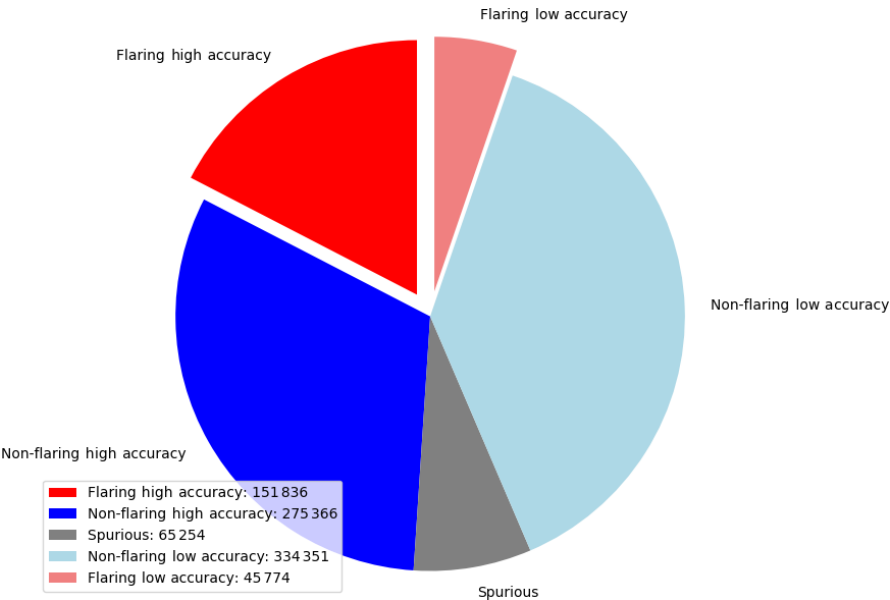
Figure 5. Classification of the 872581 detections: 65254 are spurious signals and 807327 are hotspots. Of the 807327 hotspots, 427202 are high accuracy (filtered for cloudiness and accuracy of the Planck curve fitting, see Fig. 1) and 380125 are low accuracy. After gridding (0 . 025 ◦ × 0 . 025 ◦ global grid), 6232 grid cells are classified as flaring locations (grid cells with at least 5 high-accuracy hot spots and a maximum retrieved temperature above 1500K). Flaring locations comprise 197610 hotspots, of which 151836 are high accuracy and 45774 are low